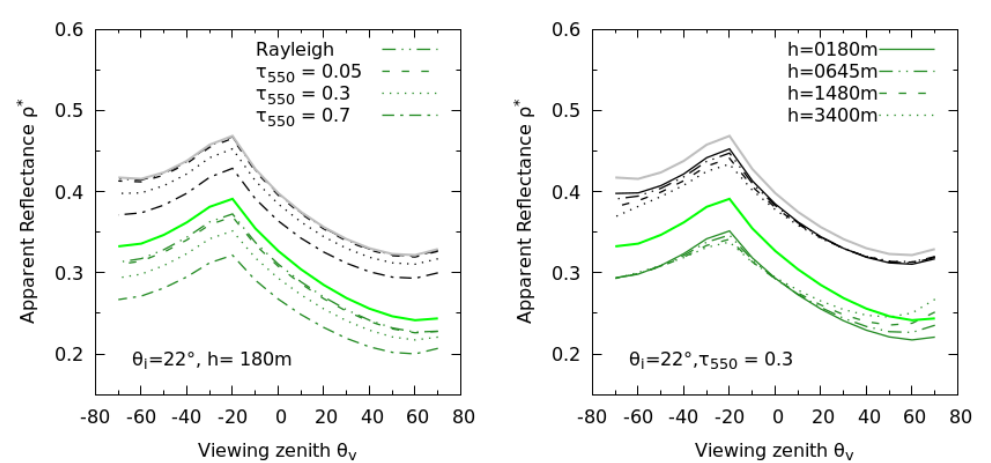
Figure 4. Left: apparent reflectance ρ ∗ in the principal plane as measured from an aircraft at 180 m with a θ s of 22 ◦ and increasing turbidity, at 0.55 µ m (green) and 0.87 µ m (black). The corresponding actual surface reflectances are given in light-green and gray. Right: effect of the aircraft altitude for a fixed τ 500 = 0.3 and the same θ i and wavelengths. Surface properties are parameterized as in Figure 2 for Railroad